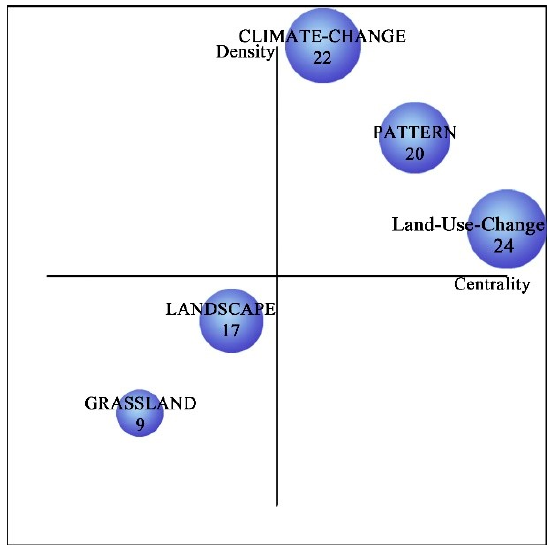
Figure 8. Farmland abandonment strategic diagram (2012–2016).